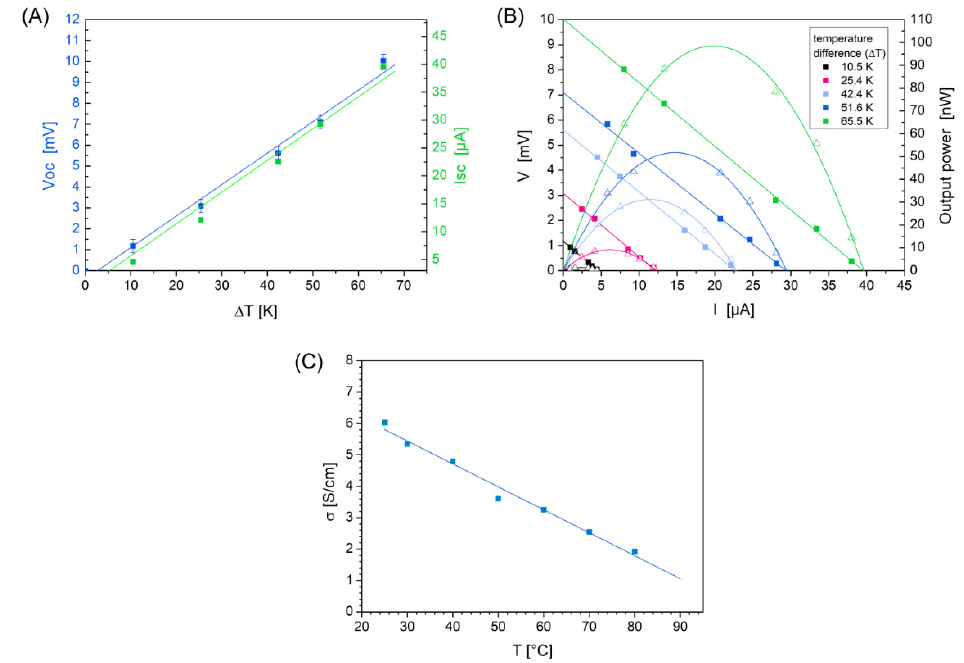
Figure 4. ( A ) Open-circuit voltage (V OC ) and short-circuit current (I SC ) versus temperature difference between hot and cold surface, a small bias voltage of − 0.01 mV was obtained. Note the scaling of the I SC axis for better visualization. S = 150 µ V/K was determined by the slope of the curve V OC ( ︵ T). ( B ) I-V characteristics with load resistances of 10, 50, 100, 500, 1000 Ω . Output power for a single textile element, ( C ) electrical conductivity was measured temperature dependent. Sputtered Cu layer was used for transformation to CuI (linear fit for visualization).